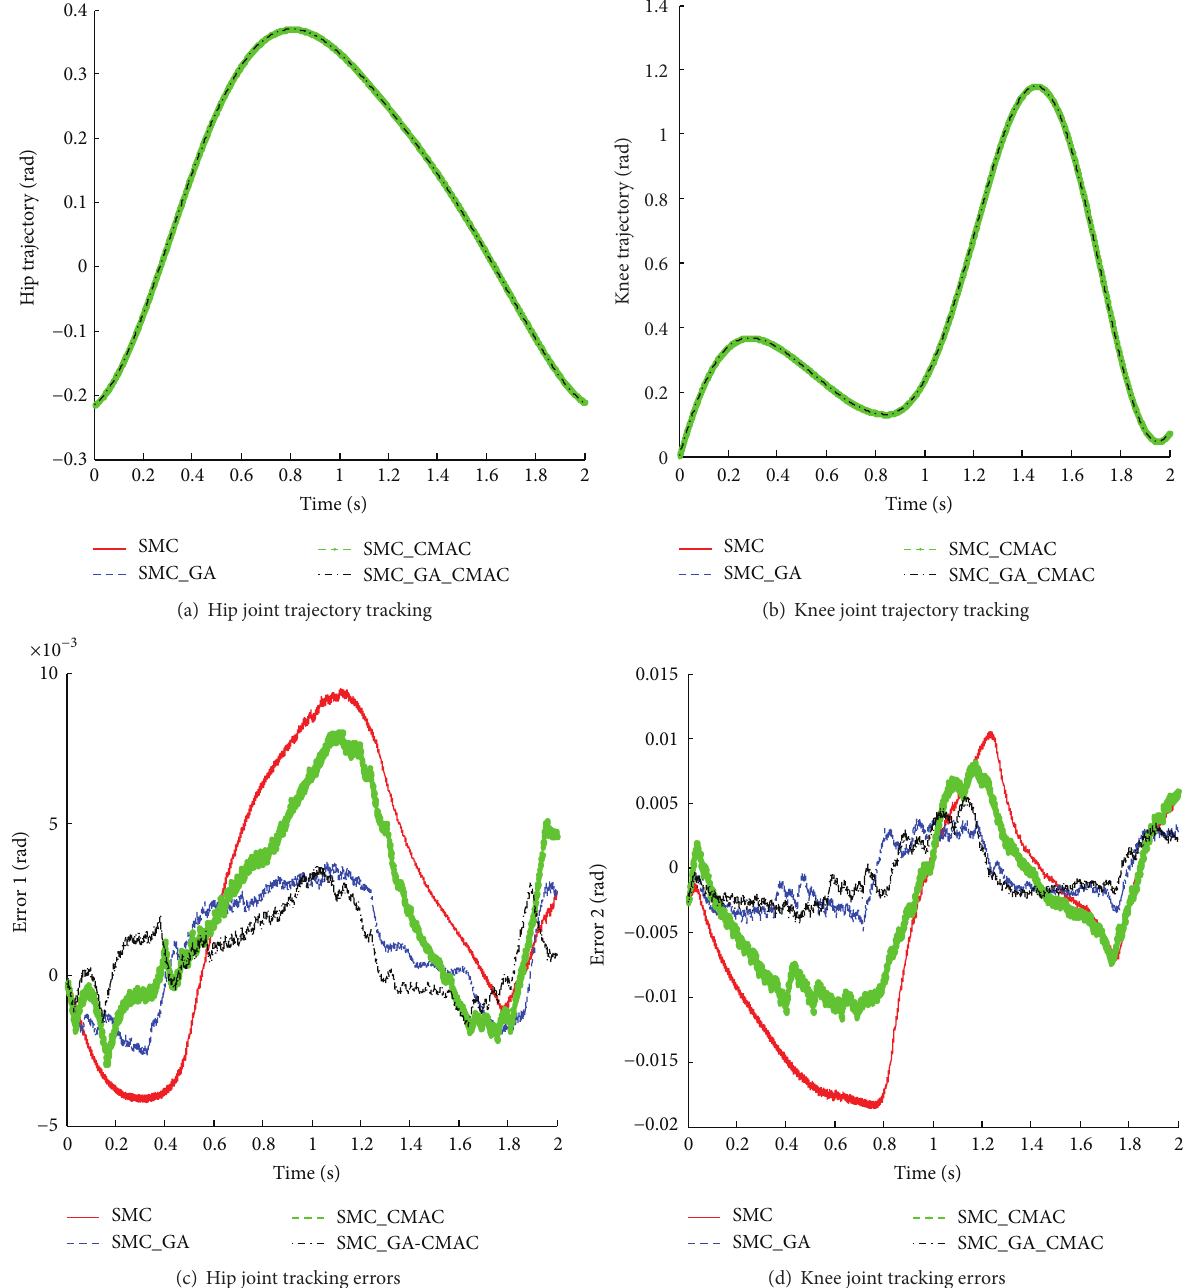
Figure 8: The performance comparisons using four methods in Case